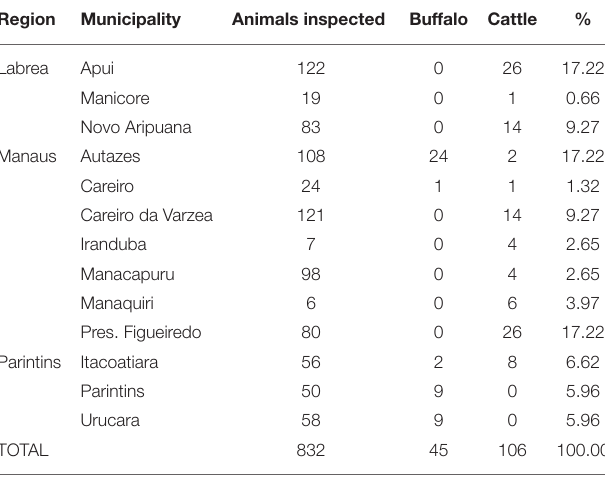
TABLE 2 | Description and descriptive statistics for animal-level risk factors evaluated for 151 animals (106 cattle and 45 buffalo) in 39 herds in Amazonas